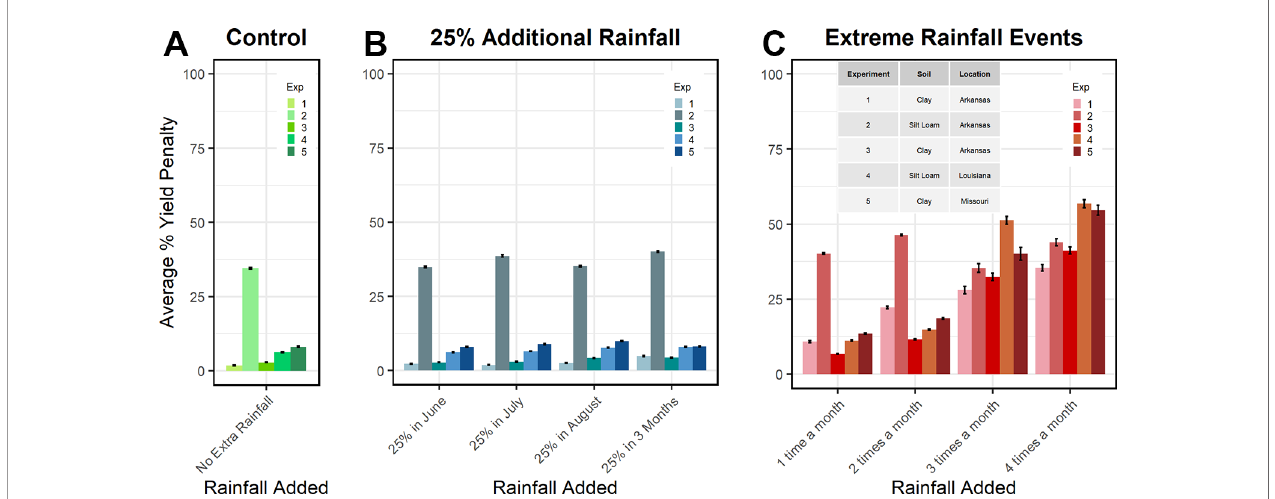
FIGURE 7 | APSIM soybean simulations of soybean % yield penalty in different soils panel (A) , 30-year weather (1988-2018) plus 25% increased precipitation amount on soybean yields panel (B) , and 30-year weather plus extreme rain evens on soybean yields panel (C) . Soil texture for each experiment is provided in panel C , further details are provided in Table 1 .